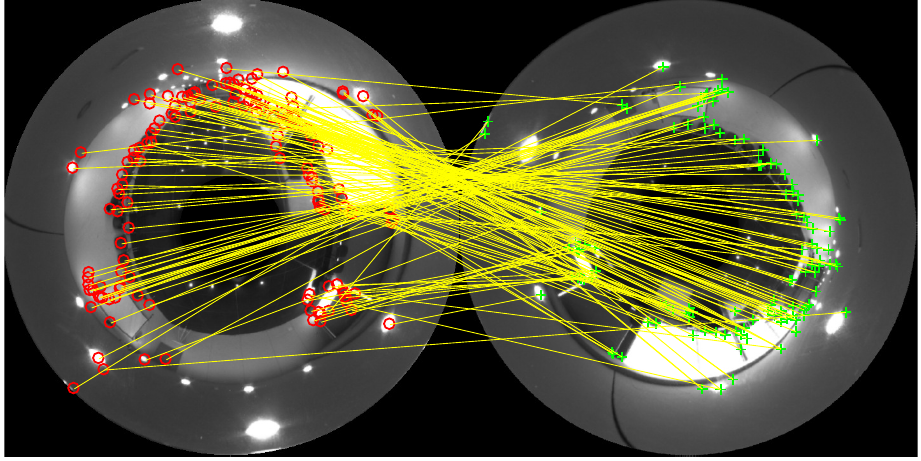
Figure 6. Matches between the reference image (left) and the test image (right) in an indoor environment. The red circles are the valid landmarks in the reference image, and the green crosses are the valid landmarks in the test image.